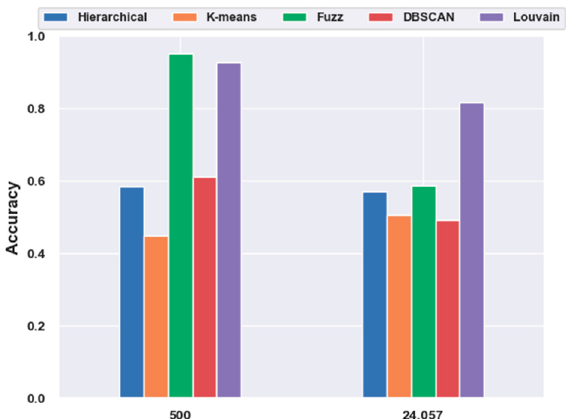
Figure 11. Comparison of the five clustering models with NFE on the mouse visual cortex data. The results from 24,057 genes were derived from the original data without dimensionality reduction. The results of 500 genes were derived from the mouse cortex data of 500 genes with feature selection. Additionally, the k values of k-nearest neighbor algorithm (kNN) used in the Louvain models were set to 500 in the 500 gene subset and 200 in the original dataset.